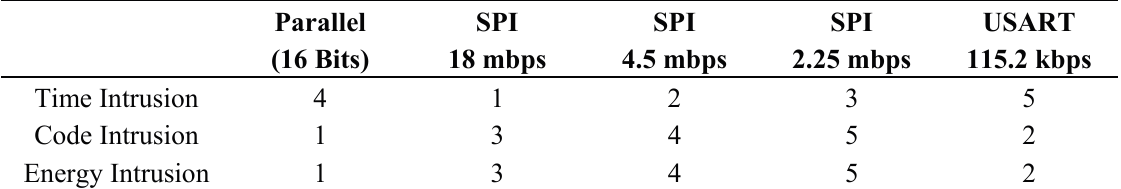
Table 8. Preference index of each sensor-monitor